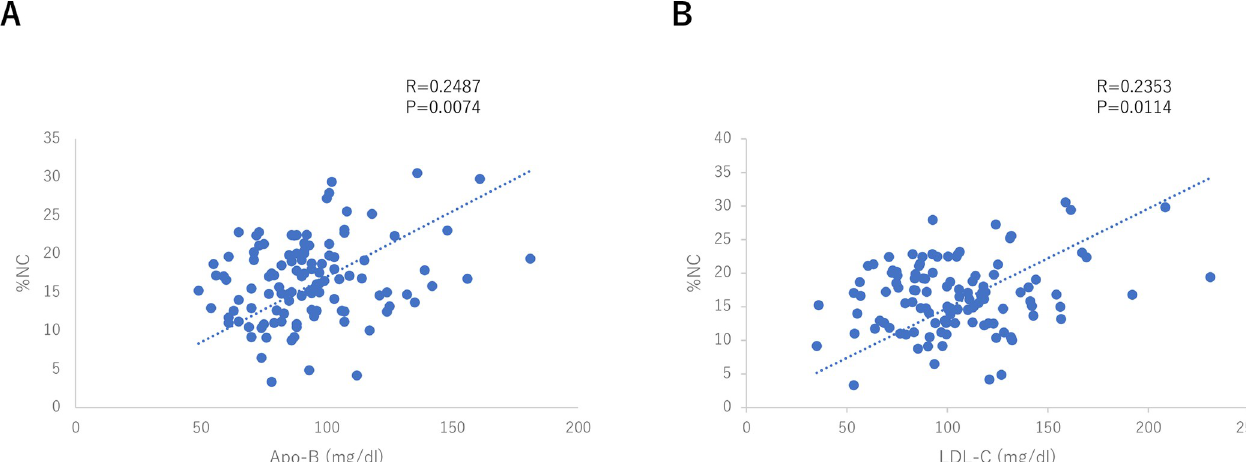
Fig 2. Correlation between %NC volume and Apo-B level and LDL-C level in all patients (n = 115). A. Correlation between %NC volume and Apo-B level in all patients. The %NC volume was significantly correlated with Apo-B level (r = 0.2487, P = 0.0074). B. Correlation between %NC volume and LDL-C level in all patients. The %NC volume was significantly correlated with LDL-C level (r = 0.2353, P = 0.0114). %NC, the percentage of necrotic core volume; Apo-B, apolipoprotein B; LDL-C, low-density lipoprotein cholesterol.